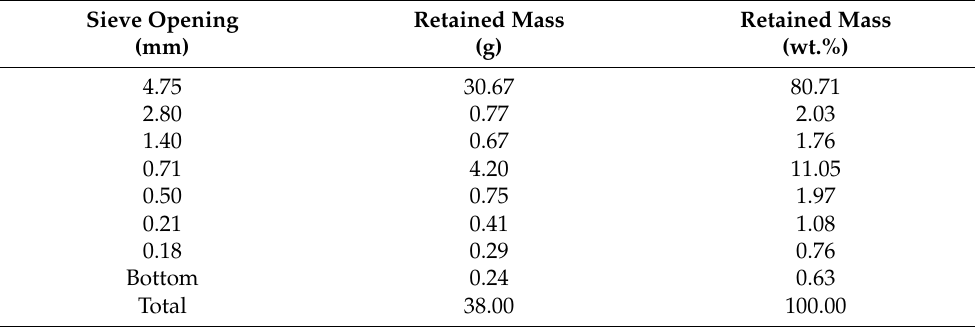
Table 2. Size classification of the thermal processing solid product after grinding operation using glass pebbles as friction agents for materials disassembling.